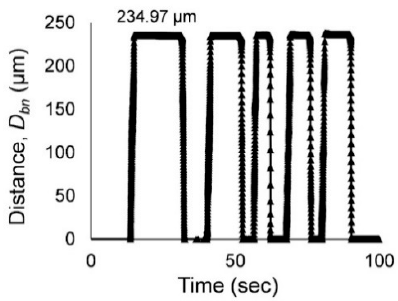
Figure 7. Variation of D bn after mounting and dismounting L-PMS.